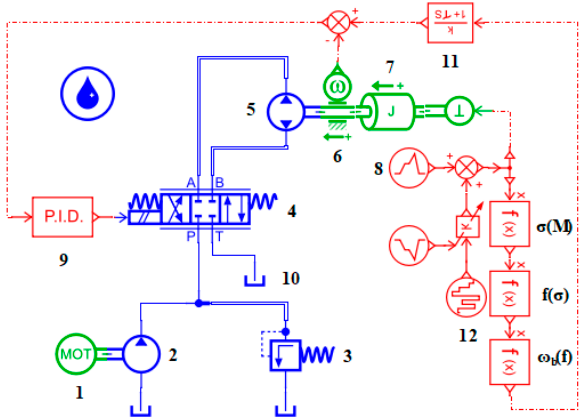
Figure 3. AMESim hydraulic schematic diagram of the rotary system of the air-borne bolting rig. 1. Asynchronous motor; 2. Hydraulic pump; 3. Safety valve; 4. Three-position four-way electro-hydraulic proportional directional valve; 5. Hydraulic motor; 6. Angular velocity sensor; 7. Moment of inertia; 8. Load torque signal; 9. PID parameter controller; 10. Tank; 11. Low-pass filter; 12. Stochastic noise. Table 1. Parameter settings of main components of the slewing rotary model.